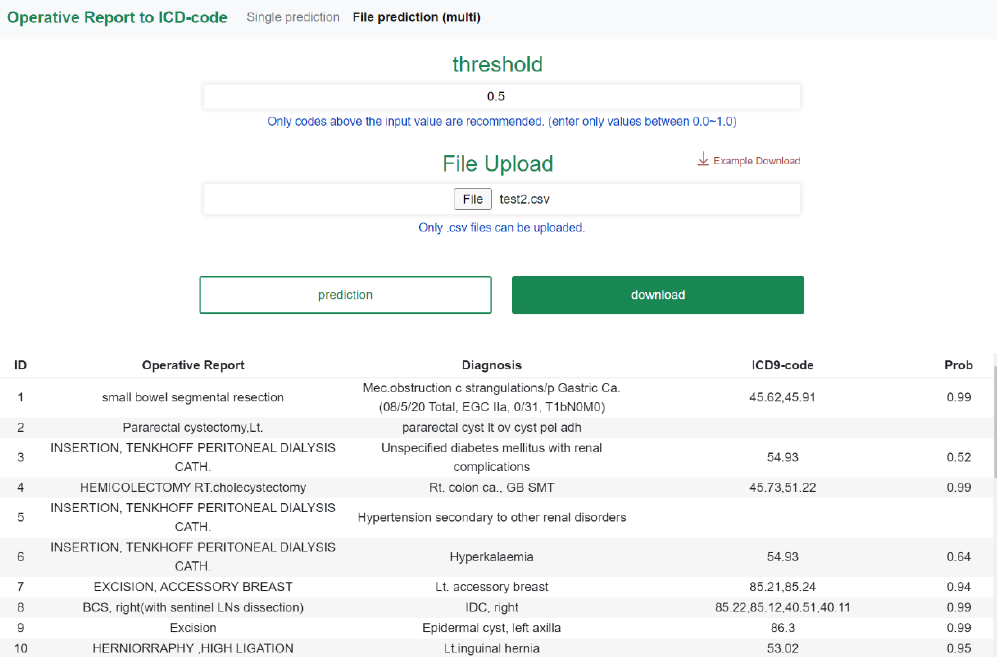
Figure 4. Multi-prediction page of the web-based application.